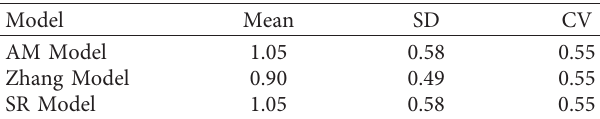
Figure 5: Comparison between the calculated value and the experimental value for the three models under concrete surface failure mode: (a) AM Model, (b) Zhang Model, and (c) SR Model. Table 7: The statistics of calculated ε under adhesive-concrete interface failure mode.